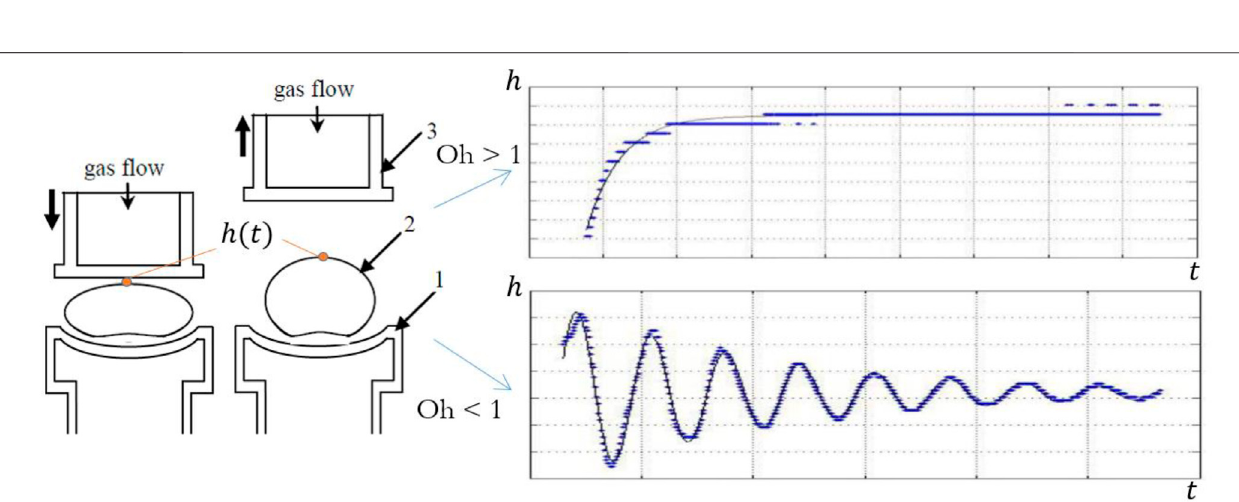
Frontiers in Energy Research |